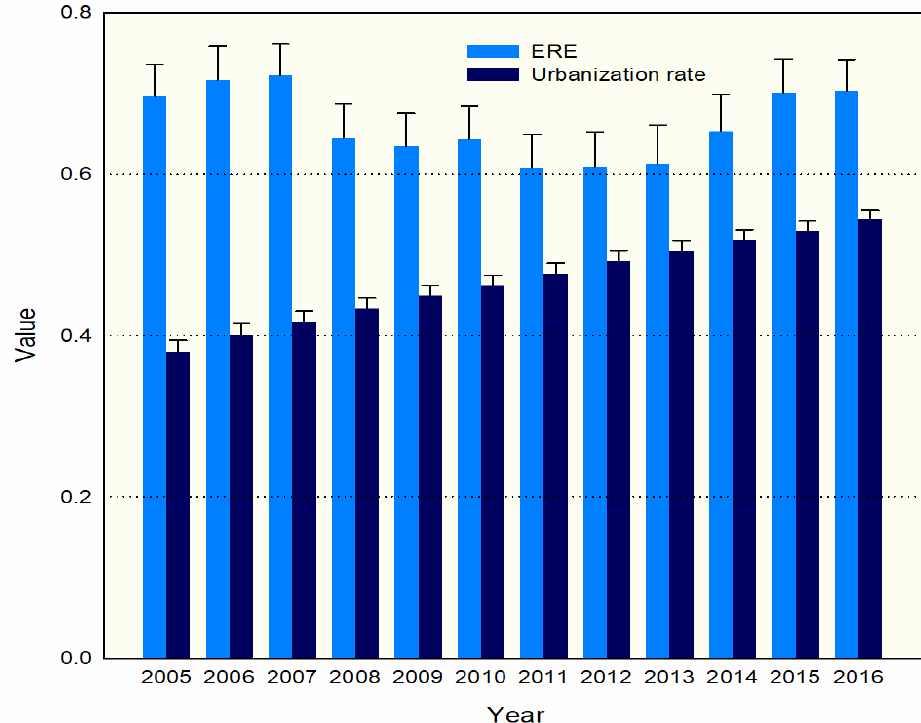
Figure 3. Overall ERE and urbanization rate grouped bar chart with error bars.